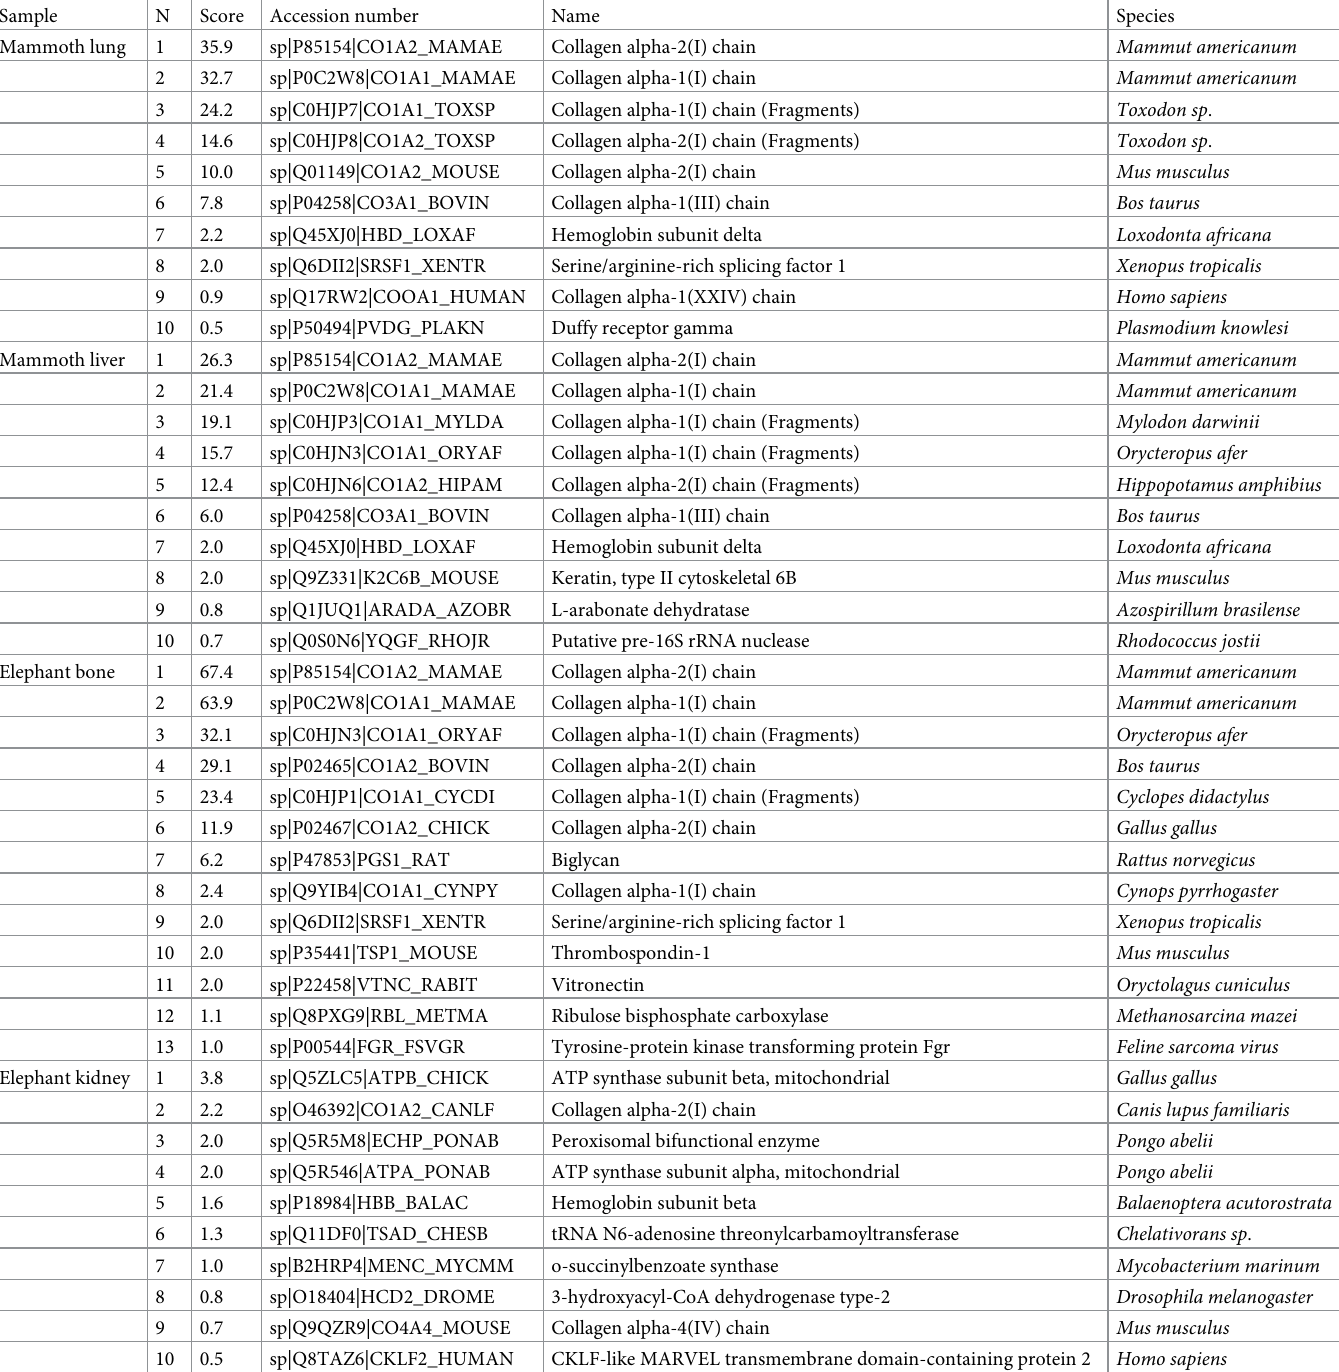
Table 3. Comparison of proteins identified by LC–MS analysis in the soft tissues from Masha and tissues from the Indian elephant.